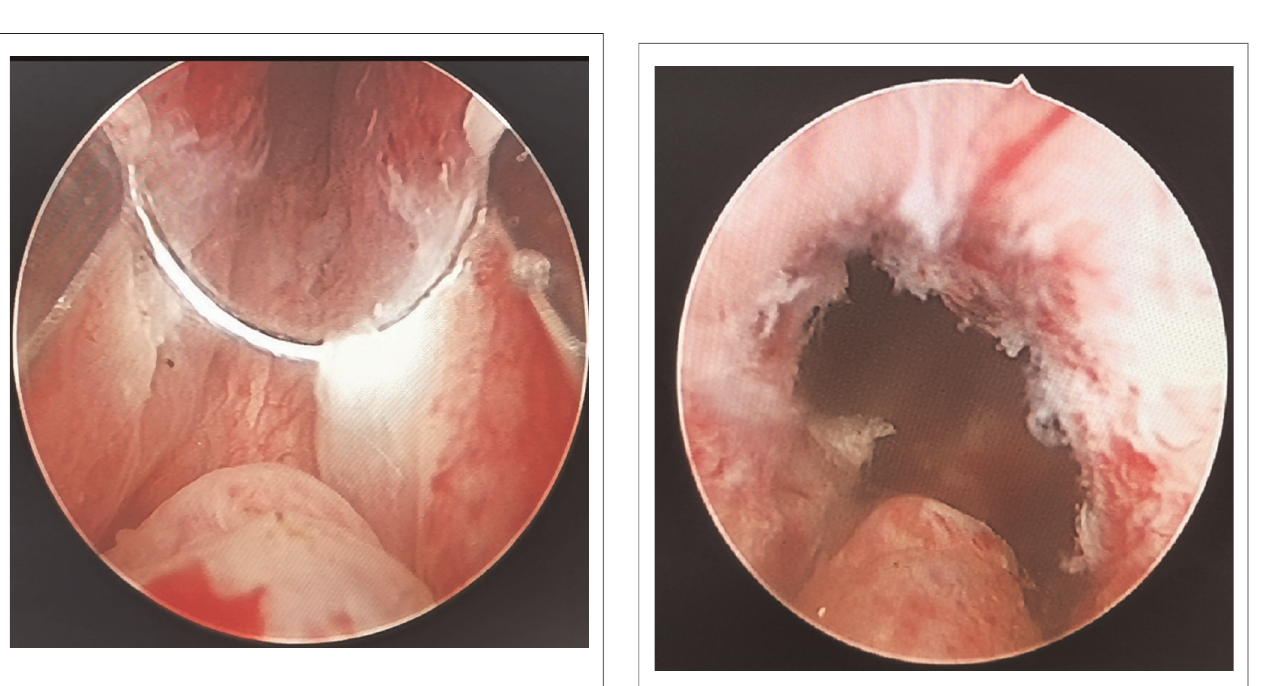
FIGURE 3 | Annular bulge of the urethral mucosa caused by the external urethral sphincter, the preserved urethral mucosa at the prostatic apex.